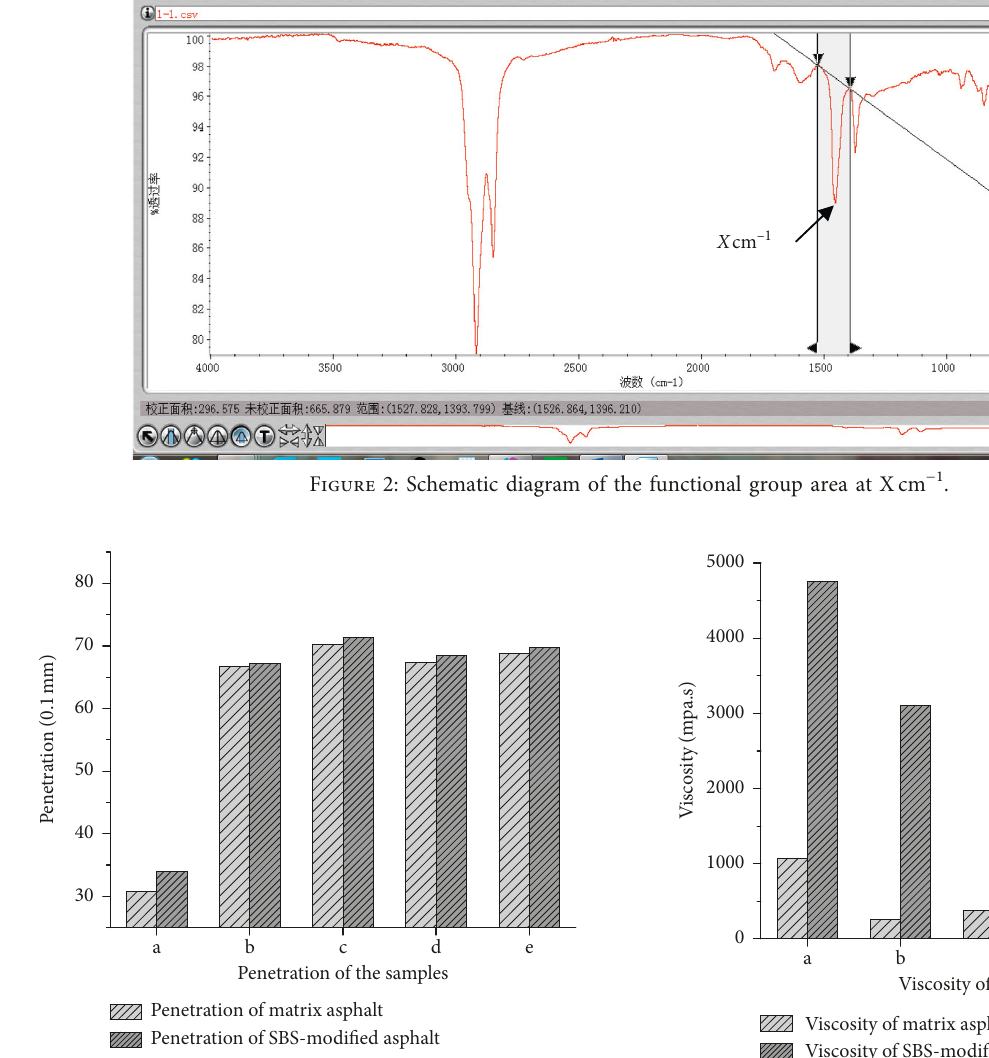
Figure 3: Penetration of the samples.